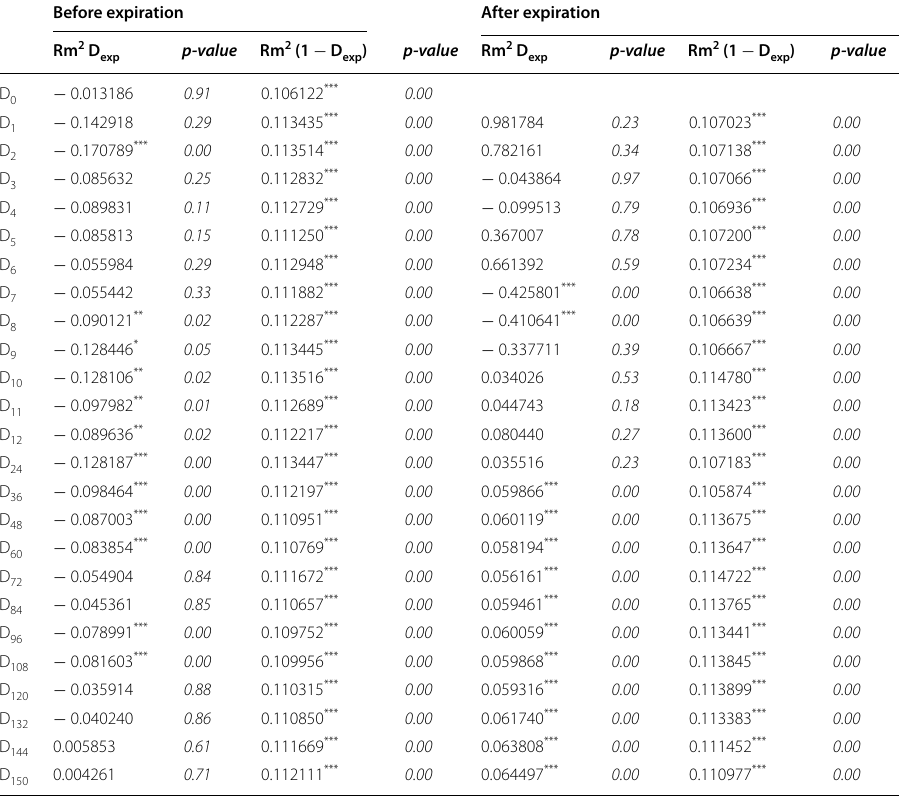
Table 6 Robustness tests using quantile